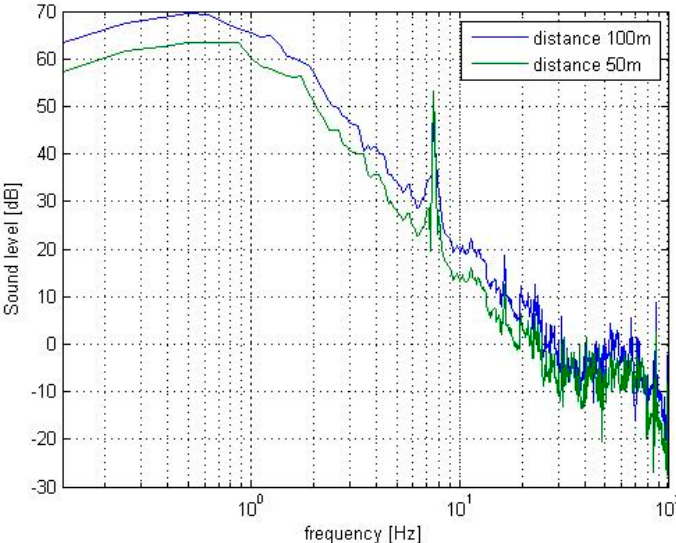
Figure 6. The rms pressure values of transformer noise in the 2–100 Hz frequency range.